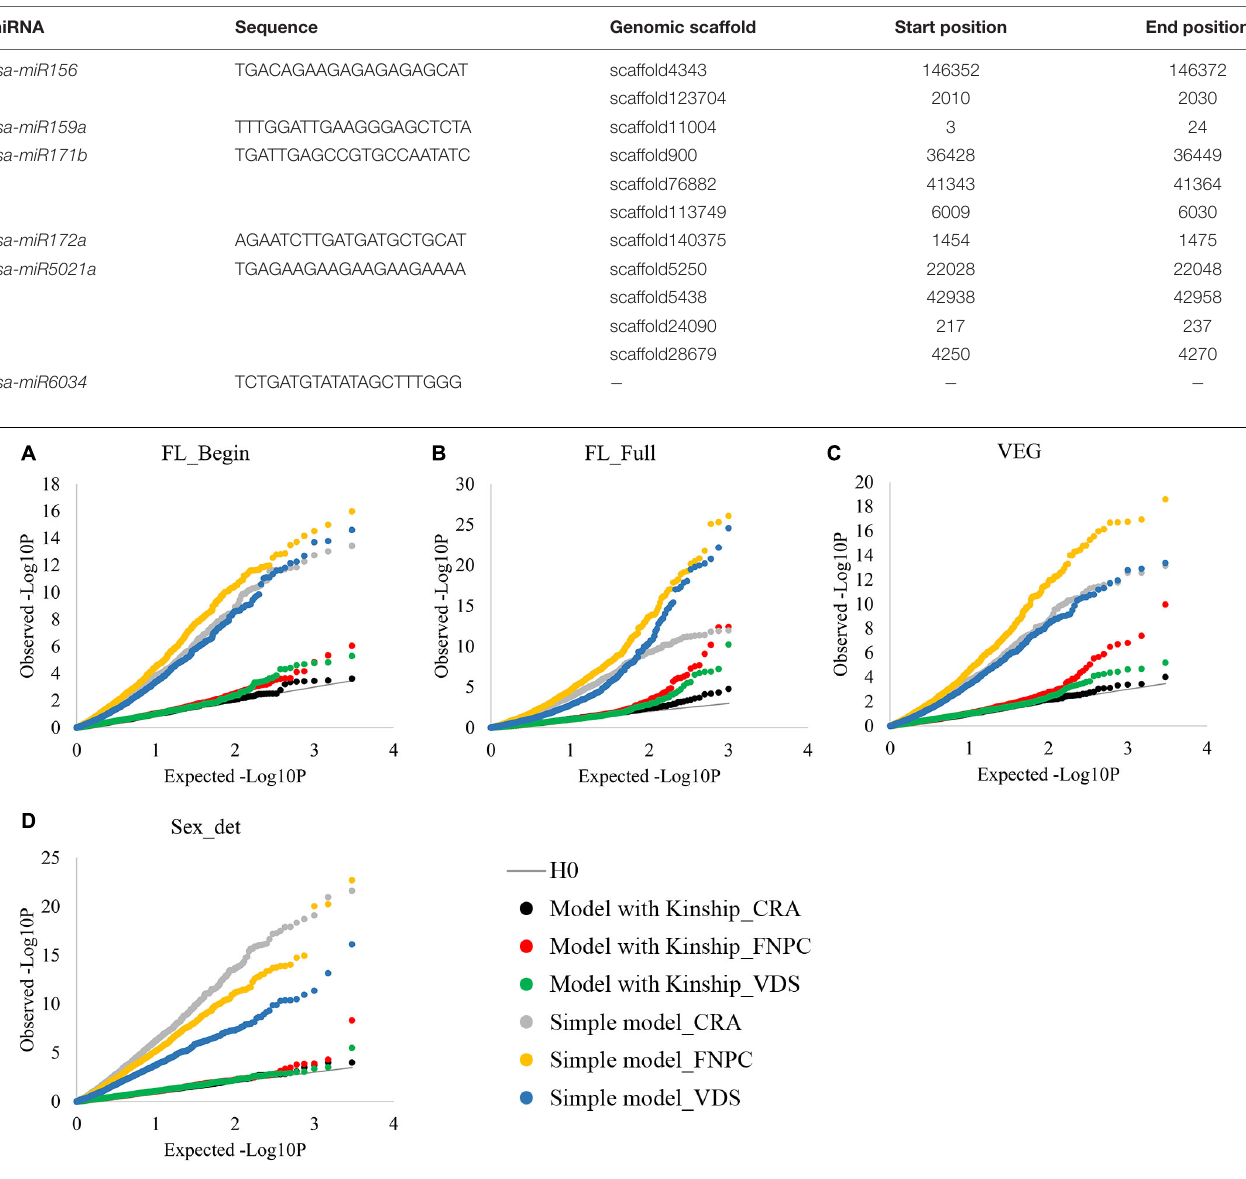
FIGURE 1 | Cumulative plot distributions of beginning of flowering (A) , full flowering (B) , length of the vegetative growth period (VEG) (C) , and sex determination (D) . The cumulative distributions of the observed –lop 10 P for the simple model (no corrected for population structure) and the kinship models (corrected for population structure) under the expectation that random SNP markers are unlinked to the polymorphism controlling the